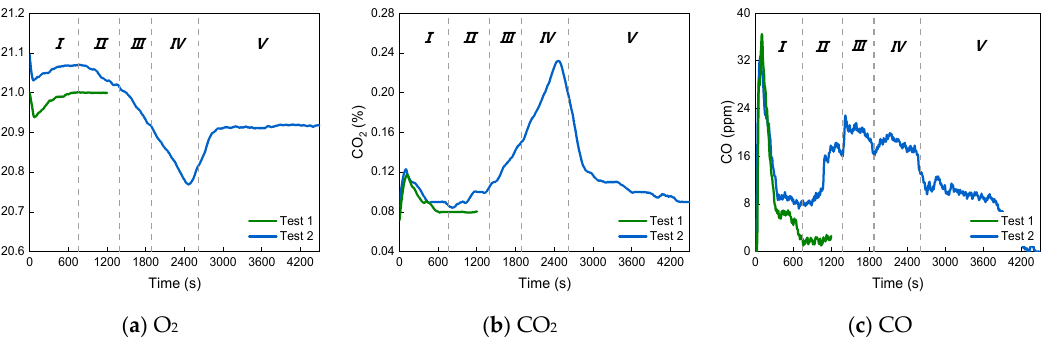
Figure 13. Concentrations of O 2 , CO 2 and CO of combustion gas for Cable ZRC-YJV-8.7/10 3 × 95 mm 2 in Test 1 and Test 2.